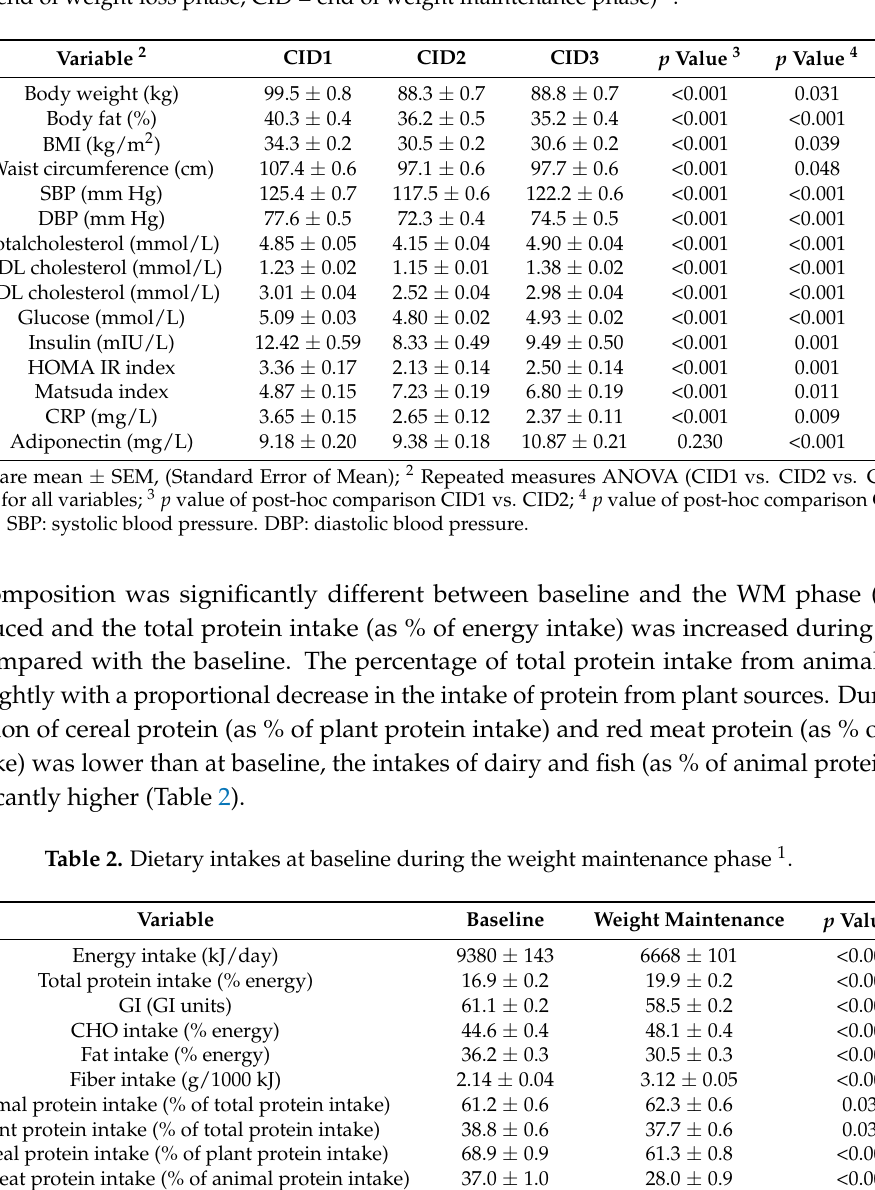
Table 1. Characteristics of the participants at the three clinical investigation days (CID1 = baseline; CID2 = end of weight loss phase; CID = end of weight maintenance phase) 1 .